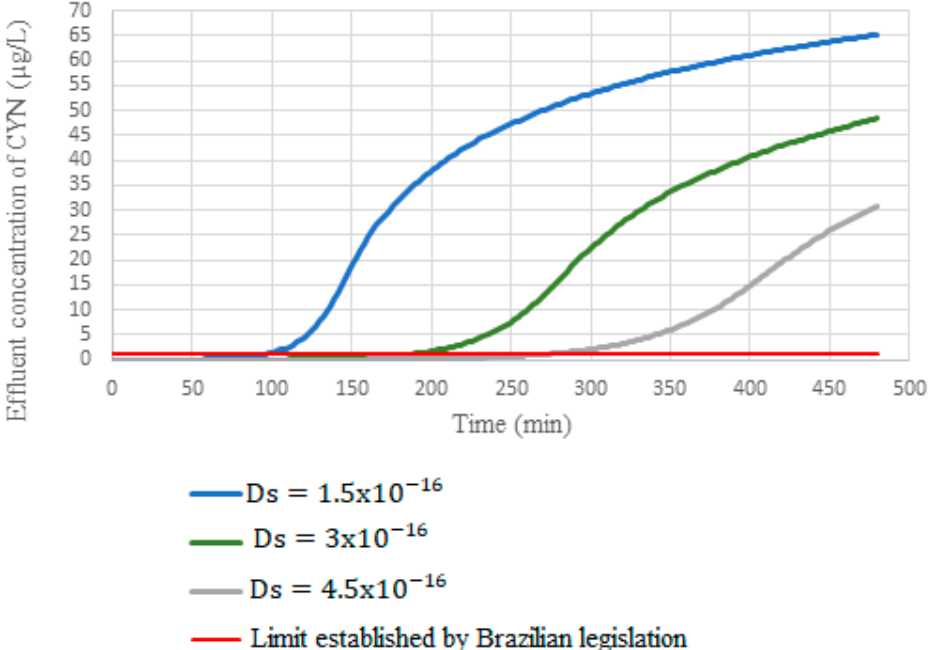
Figure 12. Sensitivity analysis of the model against changes in the values of the mass transfer coeffi- cient, Ds. Input values used in the model: EBCT = 10 min; Apparent bed density = 0.476 g/cm 3 ; Grain density = 0.850 g/cm 3 ; Average grain diameter = 0.855 mm; Initial CYN concentration = 100 µ g/L; Flow = 700 L/s; Equilibrium coefficients (Langmuir isotherm) q max = 3670 µ g/g, KL = 0.2791 L/ µ g; Film diffusion coefficient, 𝐾 (cid:3033) = 9 × 10 (cid:2879)(cid:2874) m/s.